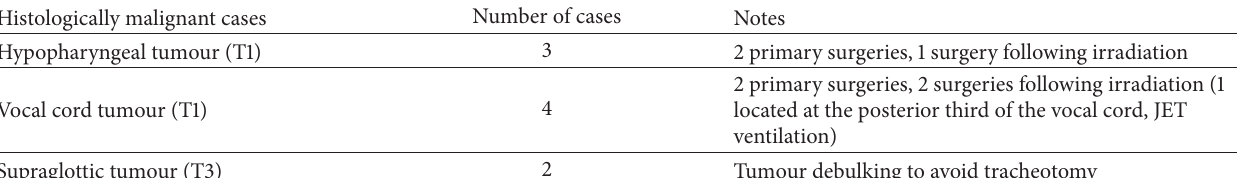
Table 2: Histologically malignant lesions and our findings.